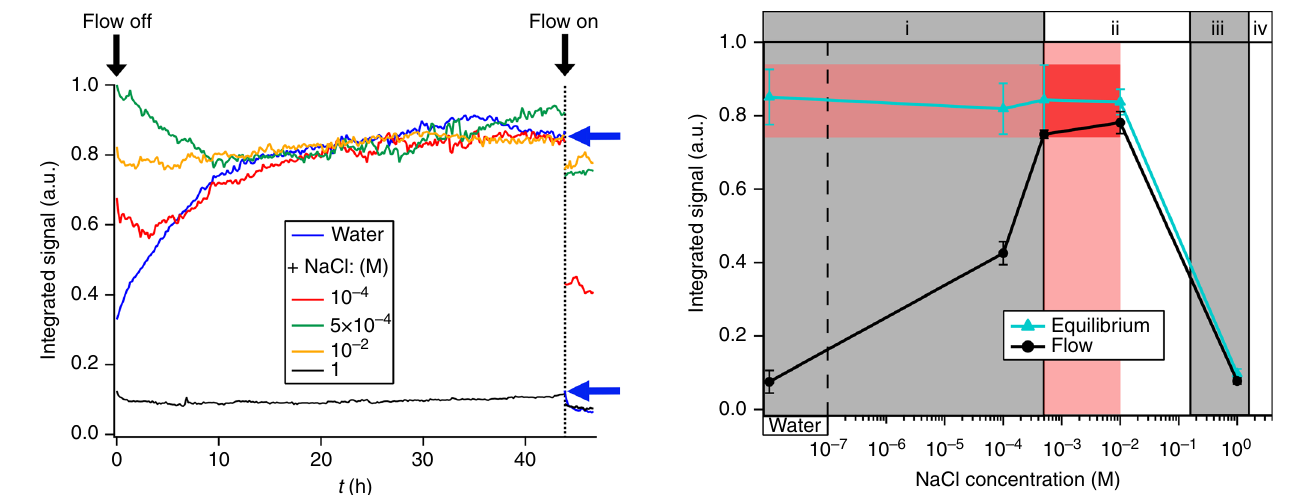
Fig. 2 Kinetics. Kinetics of the O – H-stretch SFG signal from the silica/water interface at different sodium chloride bulk concentrations under resting ( “ Flow off ” ) and fl owing ( “ Flow on ” ) conditions